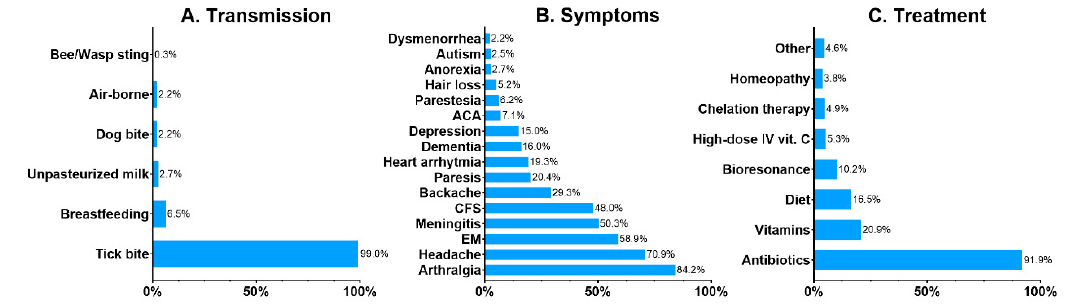
Figure 1. Respondents’ beliefs about the transmission ( A ), symptoms ( B ) and treatment ( C ) of Lyme borreliosis. Data presented as percentages. Abbreviations: ACA, acrodermatitis chronica atrophicans; CFS, chronic fatigue syndrome; EM, erythema migrans; IV, intravenous.